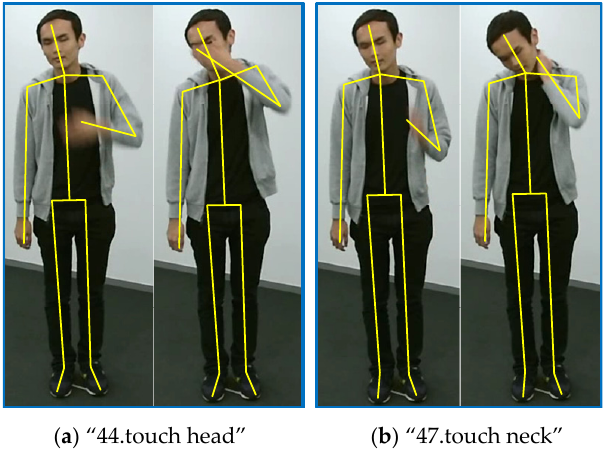
Figure 10. Two examples for class “44.touch head” and class “47.touch neck”.